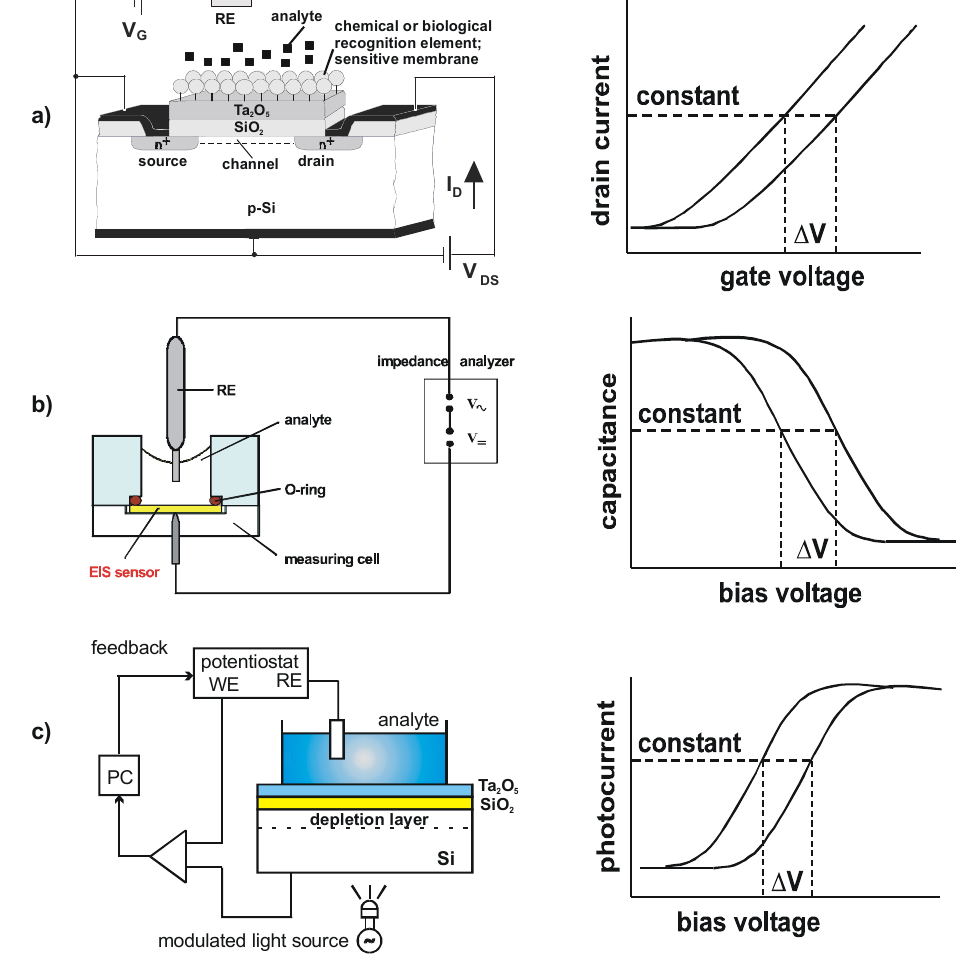
Figure 1. Detection principles of ISFET (a), EIS sensor (b) and LAPS (c), and corresponding change of respective sensor signal (V : gate voltage, V : drain-source voltage, I G DS voltage, V : dc voltage, WE: working electrode, RE: reference =